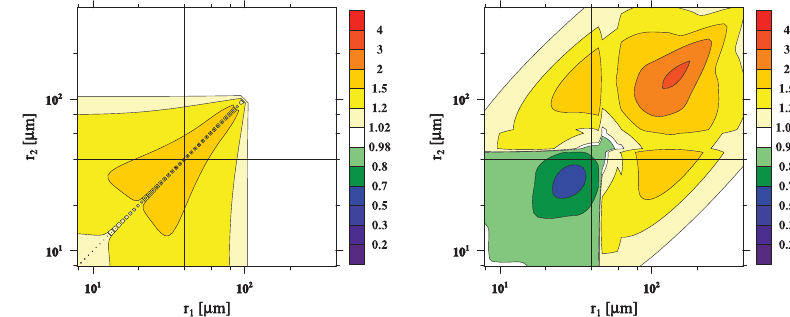
Figure 7. Ratio of the clustering effect g 12 for Re λ = 10 4 to that for Re λ = 10 3 .